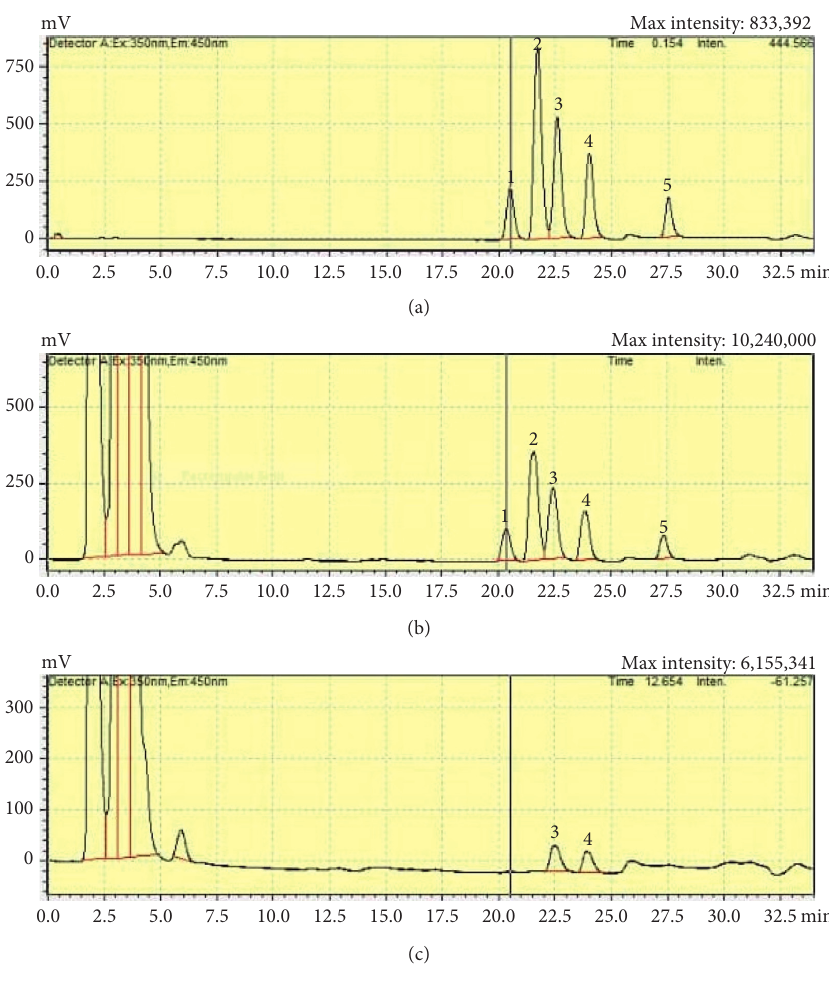
Figure 1: Typical HPLC chromatograms of (a) standard mixture of biogenic amines (30mg · L − 1 ), (b) mixed biogenic amines (50mg · kg − 1 ) in the spiked canned fish sample, and (c) biogenic amines in the extracted canned fish sample. Peak identity: tyramine (1), putrescine (2), cadaverine (3), histamine (4), and agmatine (5). Table 2: Performance of the ion-pair HPLC method for biogenic amine determination in canned tuna. Analyte